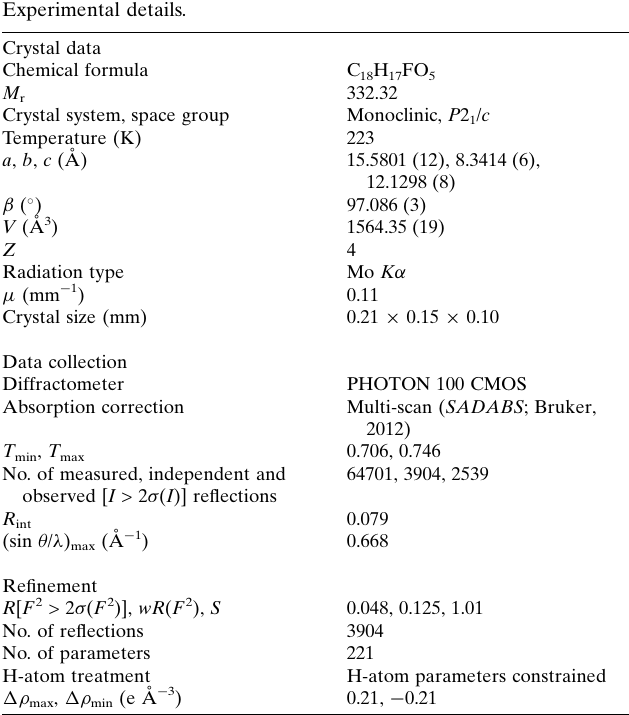
Table 2 Experimental details.